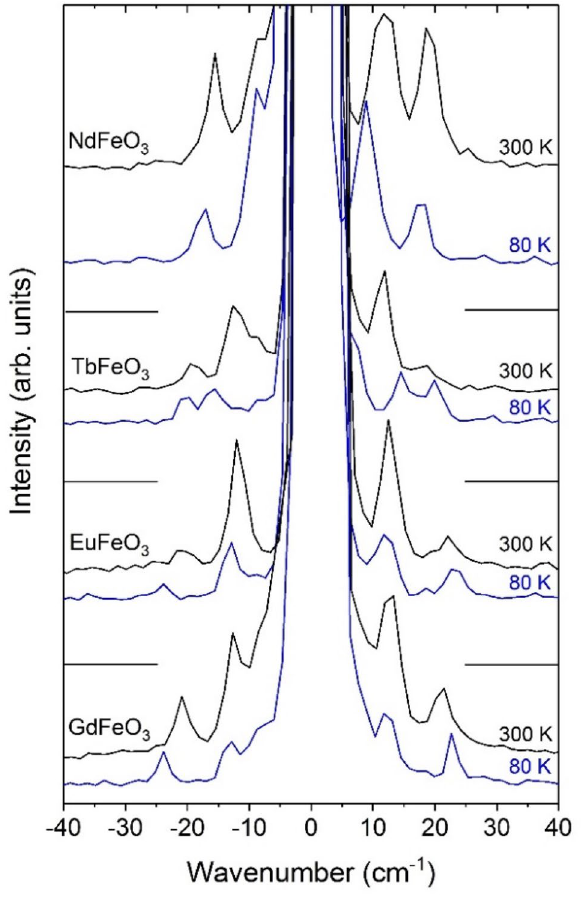
Figure 3. Representative unpolarized Stokes and anti-Stokes Raman spectra of R FeO 3 ( R = Nd, Eu, Gd and Tb), in the −40 to 40 cm −1 spectral range, recorded at 80 and 300